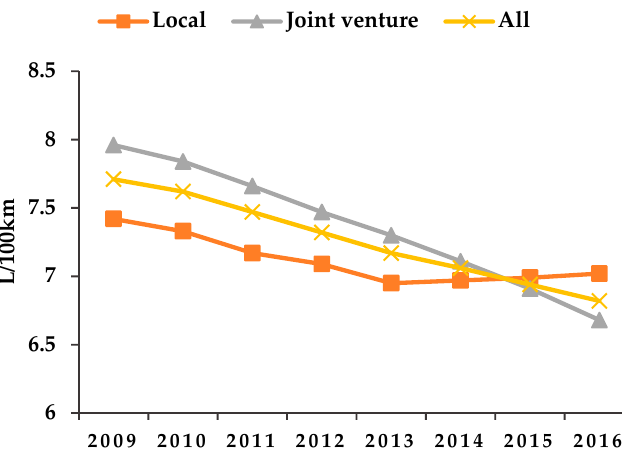
Figure 1. Production-weighted fuel consumption rate (FCR) of China’s domestic passenger vehicles in 2009–2016.